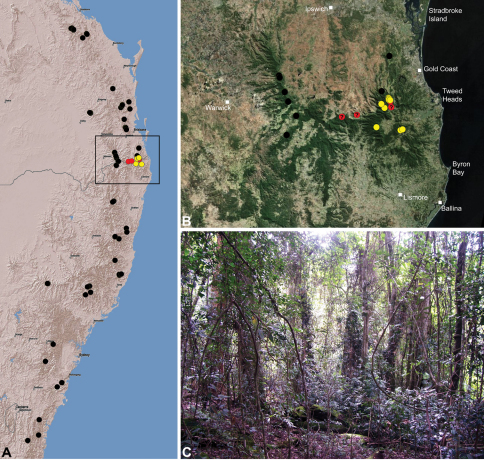
Austrarchaea nodosa (Forster, 1956), distribution and habitat: A, topographic map showing the known distribution of Archaeidae in south-eastern Queensland and eastern New South Wales, with collection localities for A. nodosa highlighted in yellow (red highlighted localities denote juvenile specimens of tentative identification); B, satellite image showing detail of inset (A); C, subtropical rainforest near the type locality – Binna Burra, Lamington National Park, Queensland (April 2010). Image (C) by M. Rix.